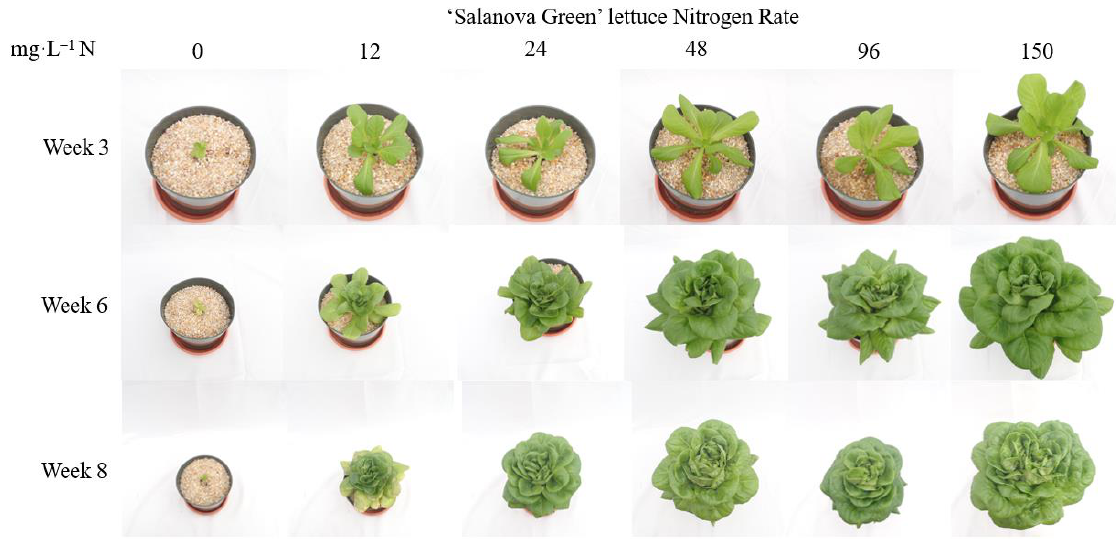
Figure 1. Visual impact of nitrogen (N) fertility rate on Lactuca sativa ‘Salanova Green’ at Weeks 3, 6, and 8. Table 2. Impact of nitrogen fertility rate on plant dry weight and nitrogen leaf tissue concentration on ‘Salanova Green’ lettuce.